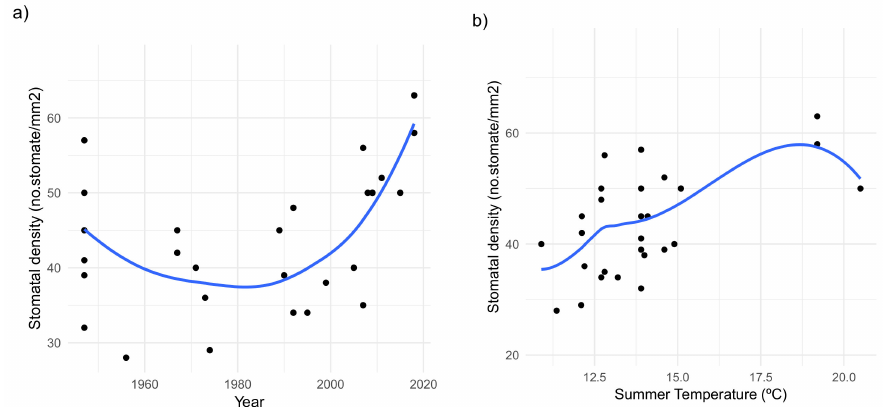
Figure 3. Generalized additive models for ( a ) changes in stomatal density over the last 72 years in S. carpetanus conserved specimens from Sierra de Guadarrama mountains; ( b ) stomatal density fluctuations in response to mean daily temperatures during the active growing season (summertime) on S. carpetanus conserved specimens. Blue lines fit the modeled data, while the immediate gray area denotes the “smoothed” parameter estimation compliant with the GAMs.